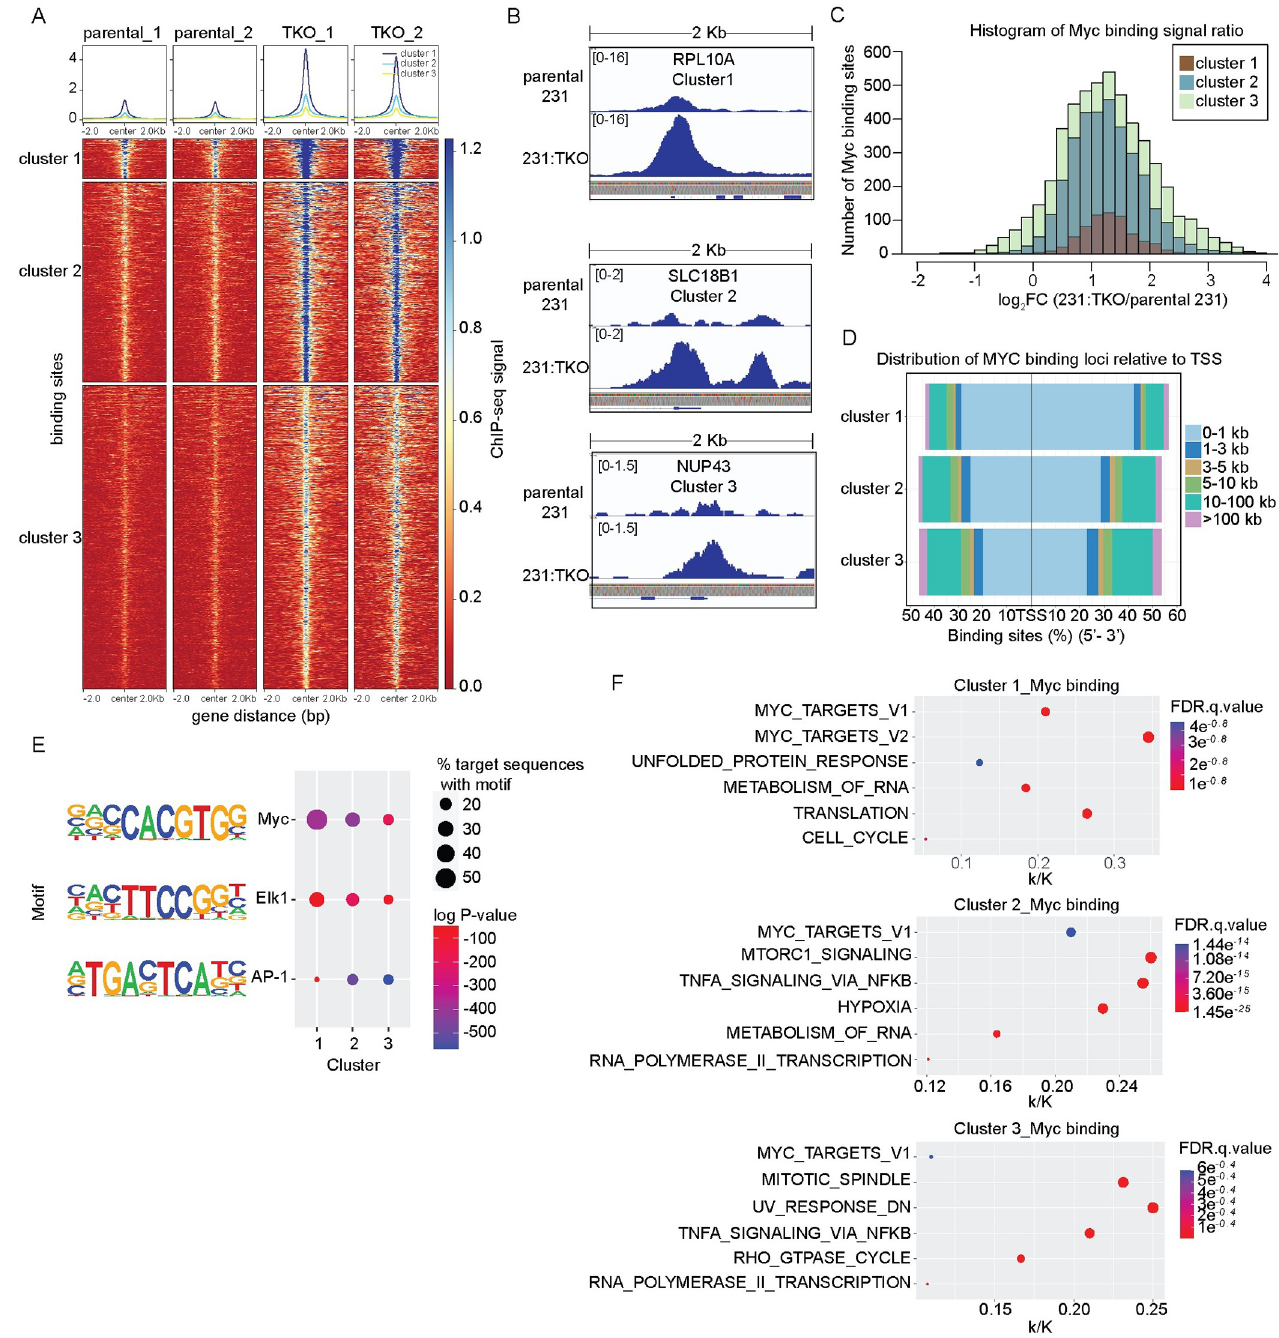
Fig 3. TXNIP regulates global Myc genomic binding. ( A ) A heatmap of Myc ChIP-sequencing data of 2 biological replicates of each parental 231 and 231: TKO cells was divided into 3 clusters using deepTools with the clustering argument of kmeans. ( B ) Myc binding, as visualized using IGV_2.5.2, to selected genes from each cluster in parental 231 and 231:TKO cells. ( C ) Histogram showing the Myc occupancy signal ratio of Myc binding sites in each cluster. Myc binding ratio was calculated by dividing the counts in 231:TKO with the counts in parental 231 cells. ( D ) The distance of Myc binding sites from TSS in each cluster was annotated using the ChIPseeker program. ( E ) Enriched sequence motifs in the proximity of Myc-occupied sites in the 3 clusters were determined using HOMER. ( F ) Myc-binding events were associated with potentially regulated genes using ChIPseeker. This set of Myc-associated genes were then evaluated for their enrichment in the Hallmark or Reactome datasets in MSigDB using GSEA. k/K value is a ratio of number of genes in our data set (k) divided by the number of genes in the indicated dataset (K). The underlying data for Fig 3C and 3D can be found in S1 Data. GSEA, Gene Set Enrichment Analysis; HOMER, Hypergeometric Optimization of Motif EnRichment; MSigDB, Molecular Signatures Database; TKO, TXNIP-knockout; TSS, transcriptional start site; TXNIP, thioredoxin interacting protein.